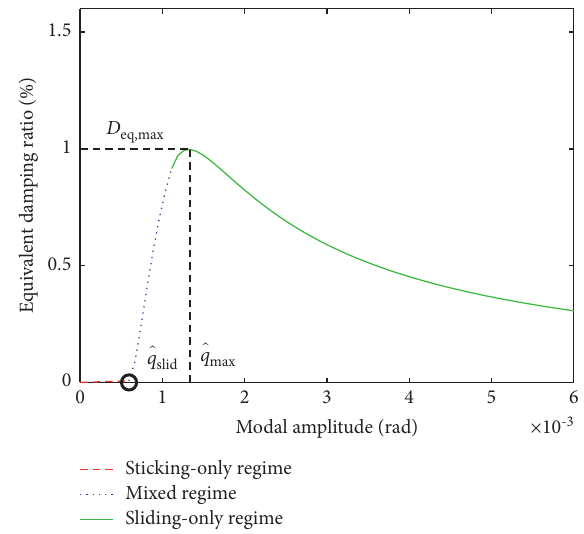
Figure 8: Semi-analytically determined damping diagram for a friction damper c.f.